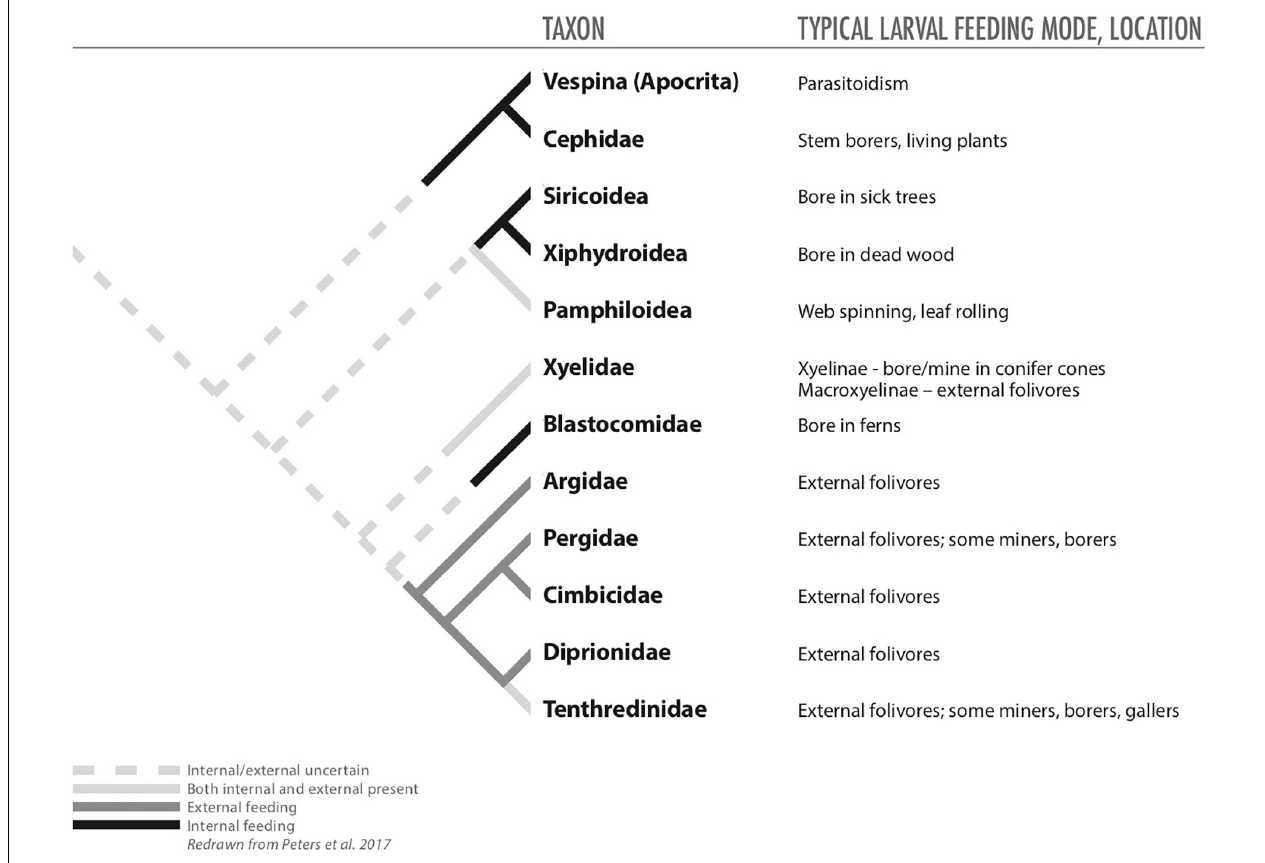
FIGURE 2 | Phylogeny of basal Hymenoptera (from Peters et al., 2017) redrawn to illustrate hypothesized distributions of internal and external feeding among taxa.